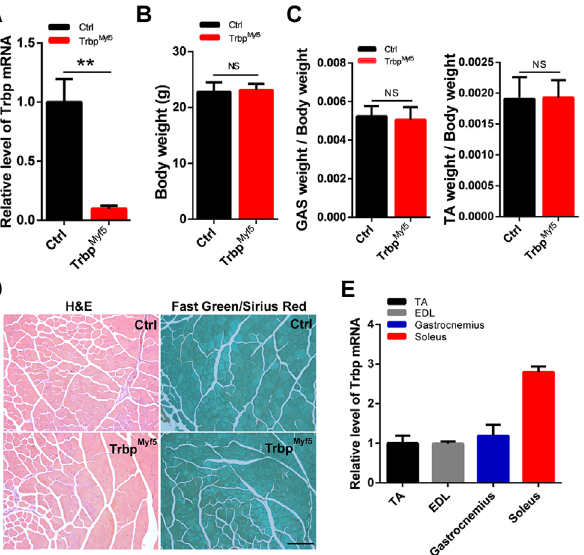
Fig 3. Phenotypic characterization of skeletal muscle-specific Trbp mutant mice. (A) qRT-PCR of Trbp mRNA levels in TA muscle tissues of 4-week control and mutant mice (n = 3); (B) Body weight of 4-week old control and mutant mice (n = 5 – 6); (C) GAS and TA muscle weight of 7-week old control and mutant mice (n = 5 – 6); (D) H&E and Fast green/Sirius red staining of transverse sections of TA muscle from 7-week-old control and mutant mice. Scale Bar = 200um; (E) qRT-PCR of Trbp mRNA levels in TA, EDL, Gastrocnemius and Soleus muscle tissues of 4-week old wild type mice (n = 3).